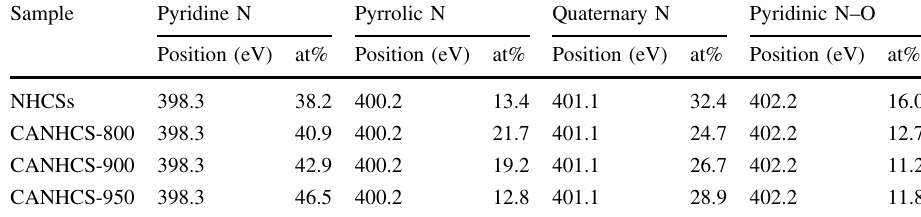
respectively [36, 50, 70]. The peak positions and relative compositions of different N groups of trained from the N1s